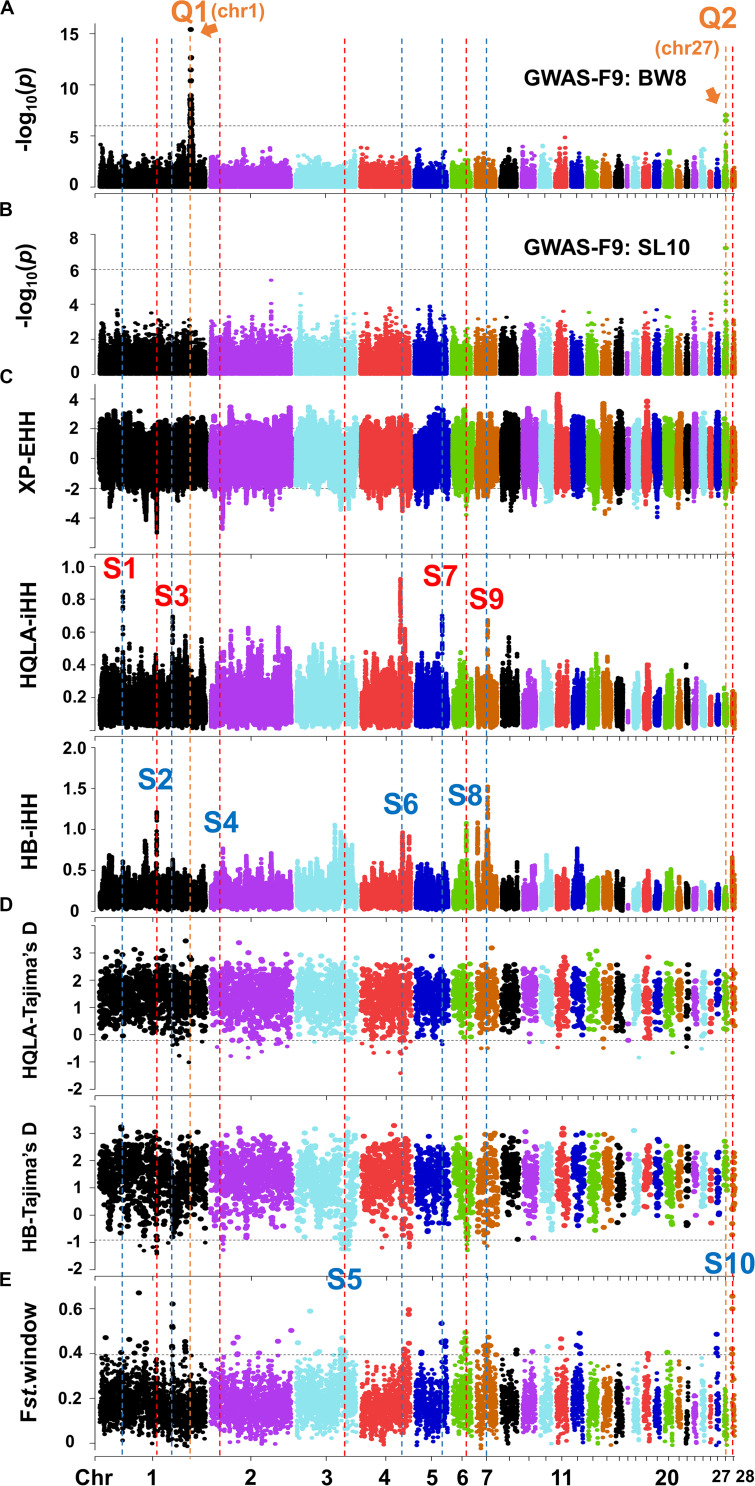
Joint analysis of GWAS in F9 and selection signature identification in F0. The Manhattan plots for BW8 (A) and SL10 (B). The genome-wide 5% significance threshold -log10P was 5.99. (C) XP-EHH and iHH in HQLA and HB using a ±2 cutoff (top 4.4% genomic region). (D) Tajima’s D in HQLA and HB and (E) the Fst value with a 200 Kb window using the 99th percentile cutoff. The orange vertical dashed (marked by the letter Q) represents the QTL interval, and the red and blue vertical dashed (marked by the letter S) represent the selection signature intervals dominated by HQLA and HB, respectively.